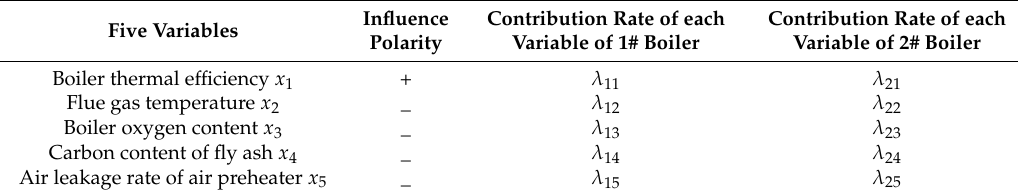
Table 1. The different influence polarity of five variables and its contribution rate to the performance of boiler combustion process.